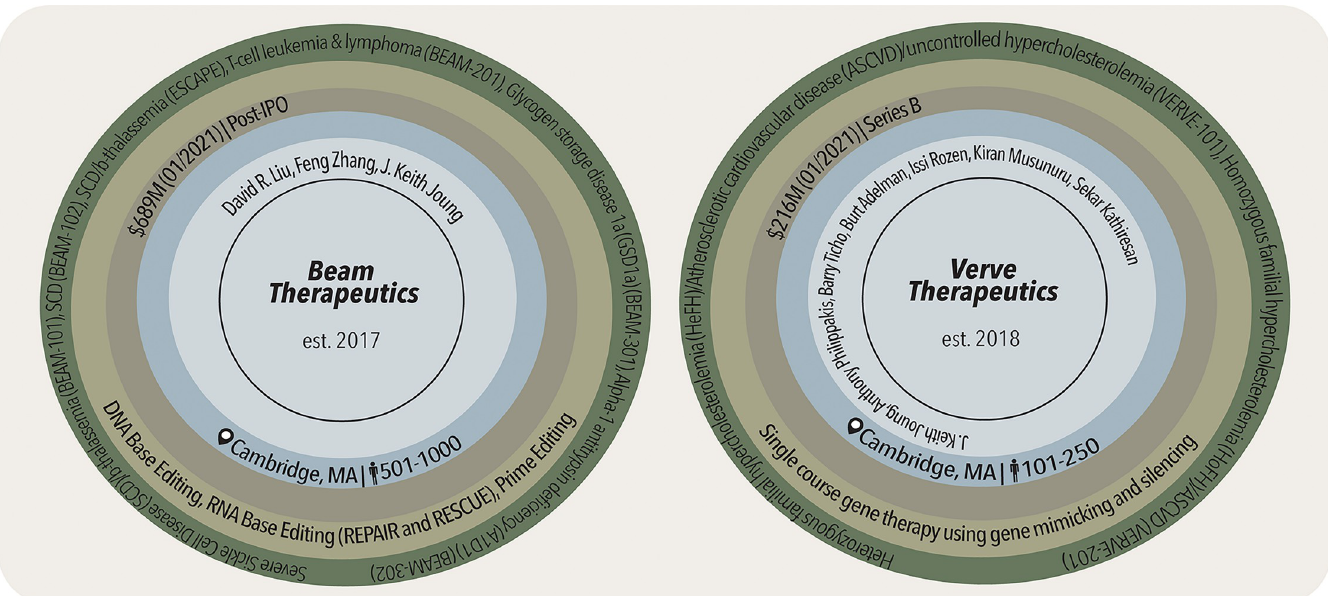
Fig 2. Profiling Beam Therapeutics and Verve Therapeutics. Starting with the inner most ring and moving outward, these profiles include the year each company was established, key scientific founders, location of headquarters and number of employees, last reported total funding and round acquired, technology specialization, and targeted indications addressed with the company’s specialized technology. Defined clinical trial candidates are denoted in parentheses. Left : profile on Beam Therapeutics. REPAIR is RNA editing for programmable A-to-I replacement and RESCUE is RNA editing for specific C-to-U exchange. Right : profile on Verve Therapeutics. Additional profiles can be found within S1